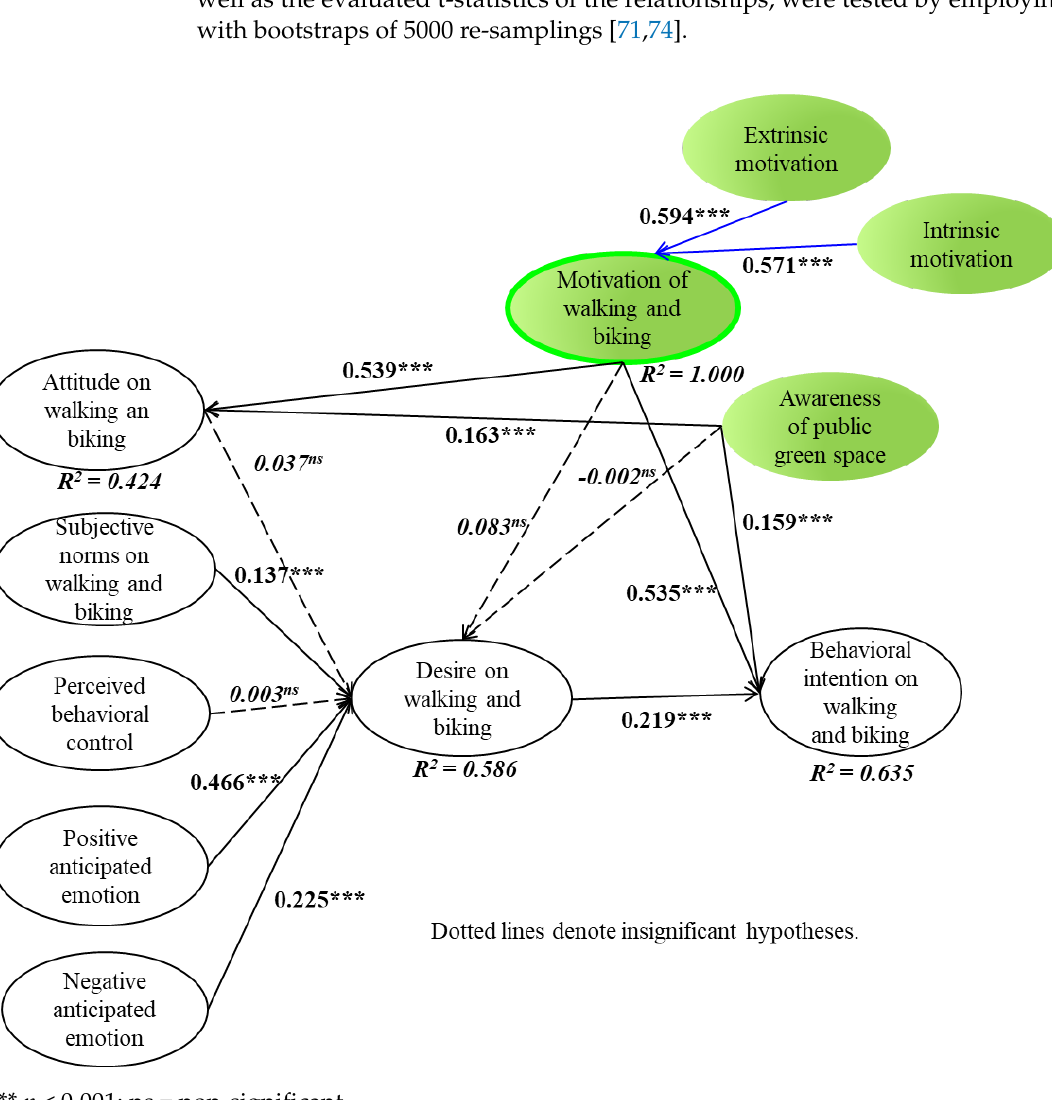
Figure 2 . Results of path analysis. Figure 2. Results of path